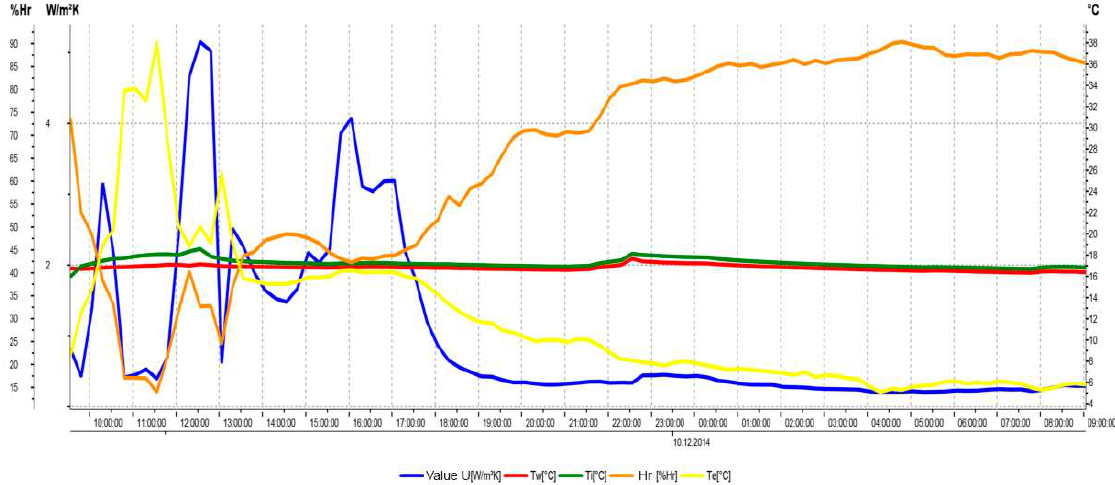
Figure 17. U e measurements in the Casa Zaranda envelope.